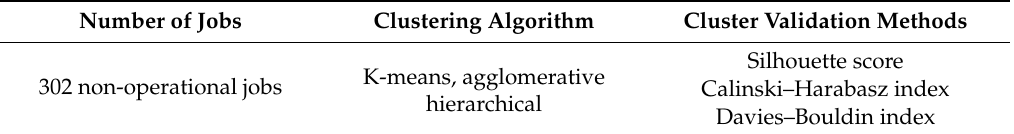
Table 5. Experiment one